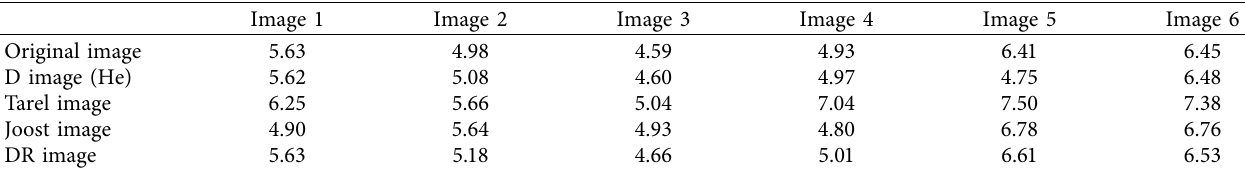
Table 5: Entropy for the six sets of effect